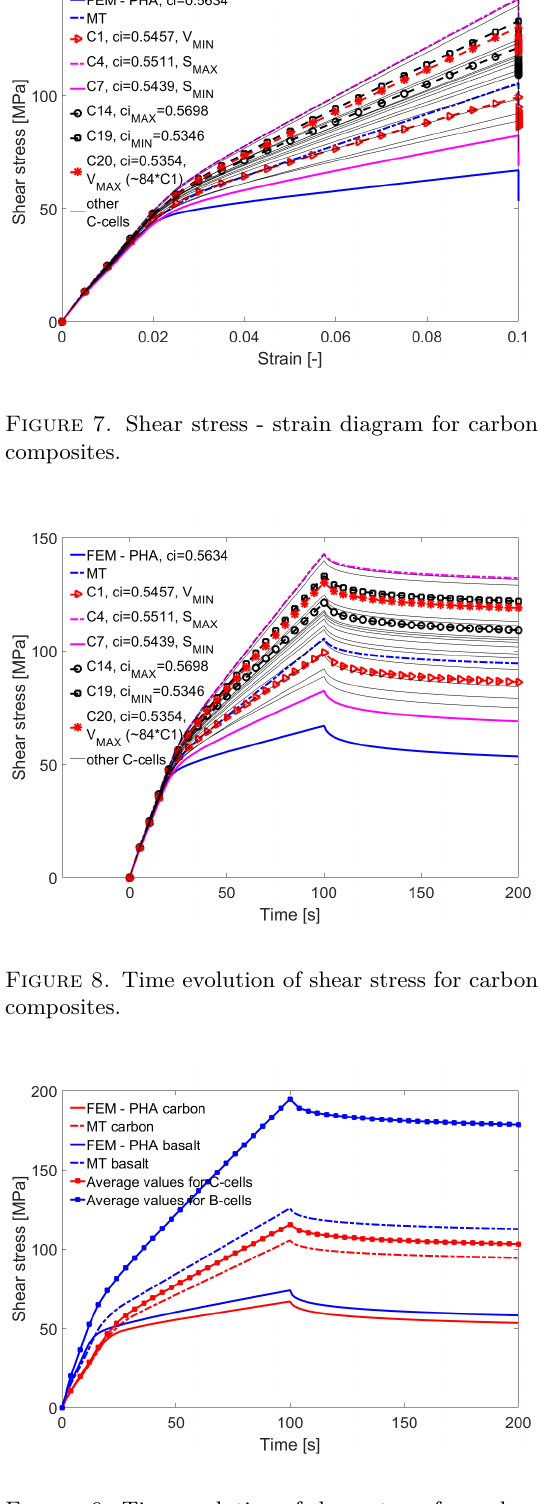
Figure 9. Time evolution of shear stress for carbon and basalt